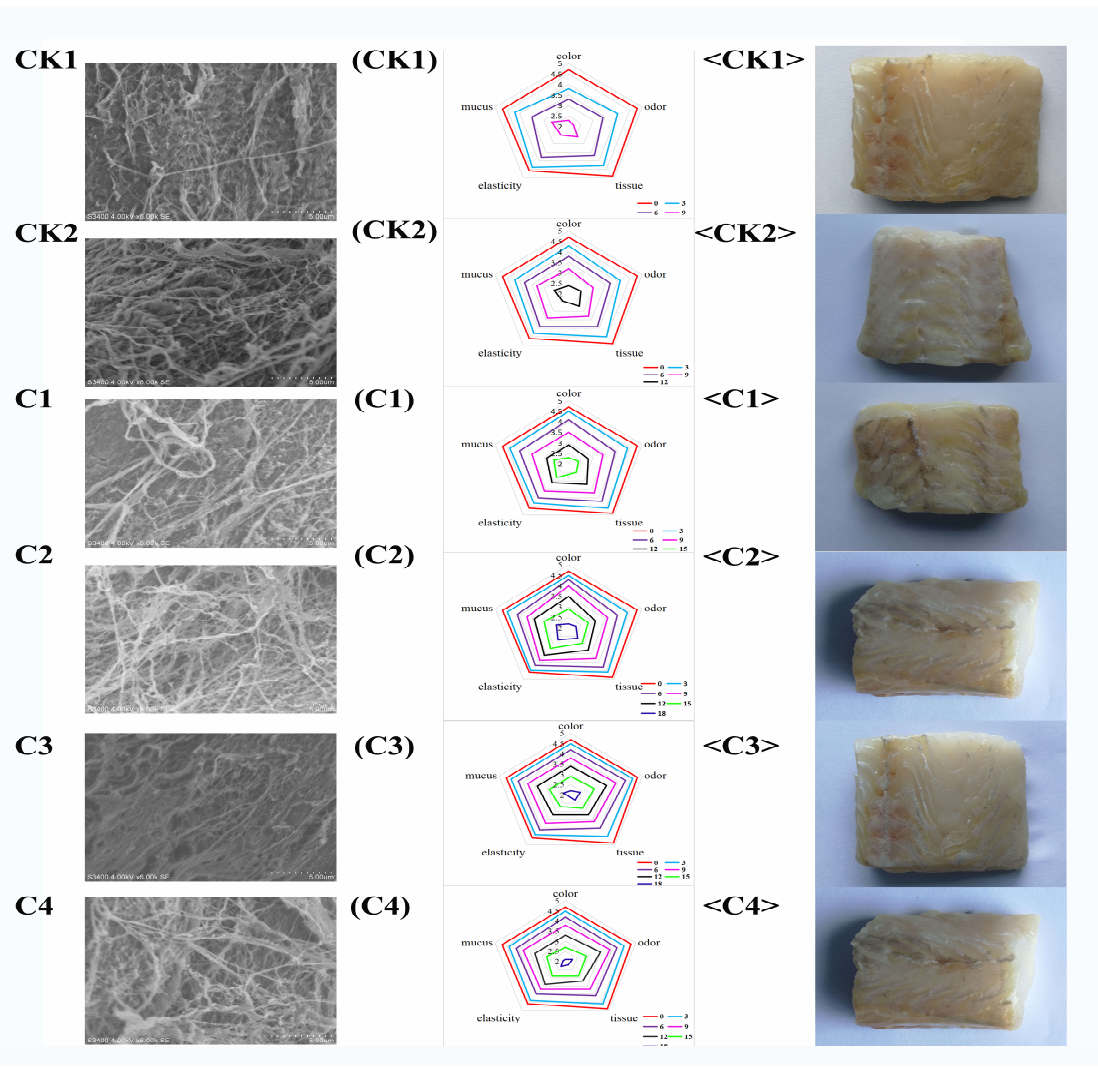
Figure 5. Changes in microstructure (CK1–C4), sensory evaluation results ((CK1)–(C4)), and appearance (<CK1> – <C4>) of half-smooth tongue sole fillets during refrigerated storage (CK1: Chitosan coating without rosmarinic acid or ε-PL; CK2: Chitosan coating with 30 mg/kg rosmarinic acid; C1/C2/C3/C4: Chitosan coating with 30 mg/kg rosmarinic acid and 0.05%/0.10%/0.15%/0.20% ε-PL).